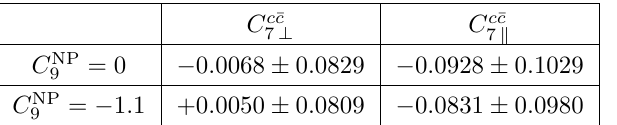
Table 7 . Charm contribution entering C 7 as obtained from the (cid:12)t for n = 1 in the SM (table 3) and in presence of NP C NP